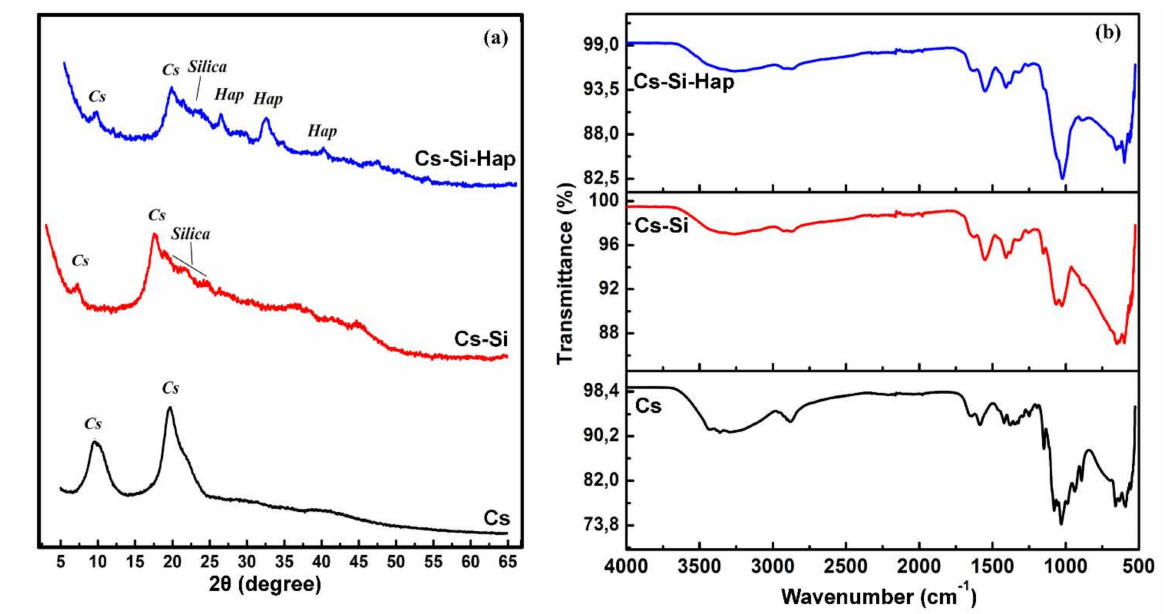
Figure 2. XRD patterns ( a ), and FT-IR spectra ( b ) of Cs- and Cs-based